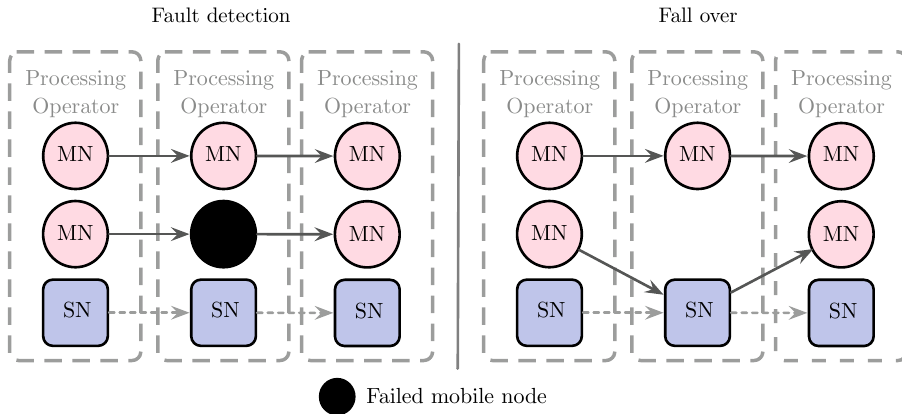
Figure 5. Example scenario of a mobile node failure and fail over process in